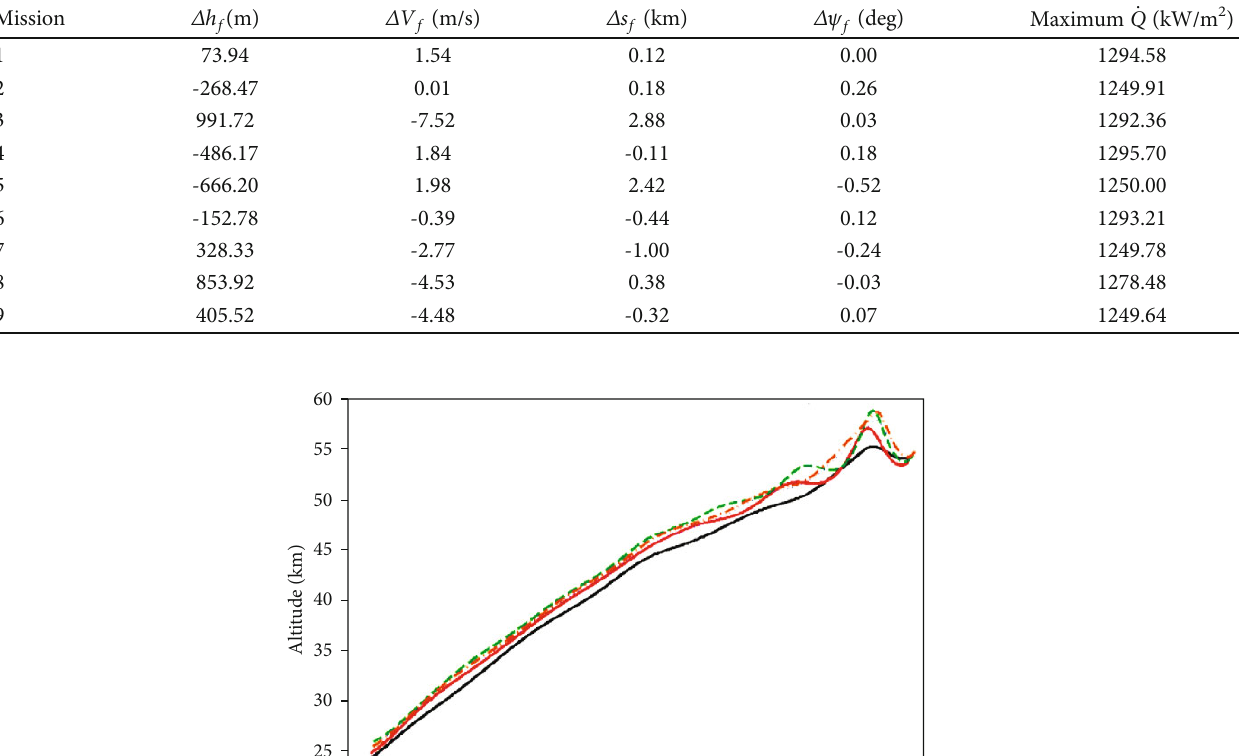
Table 2: Terminal condition precision for all